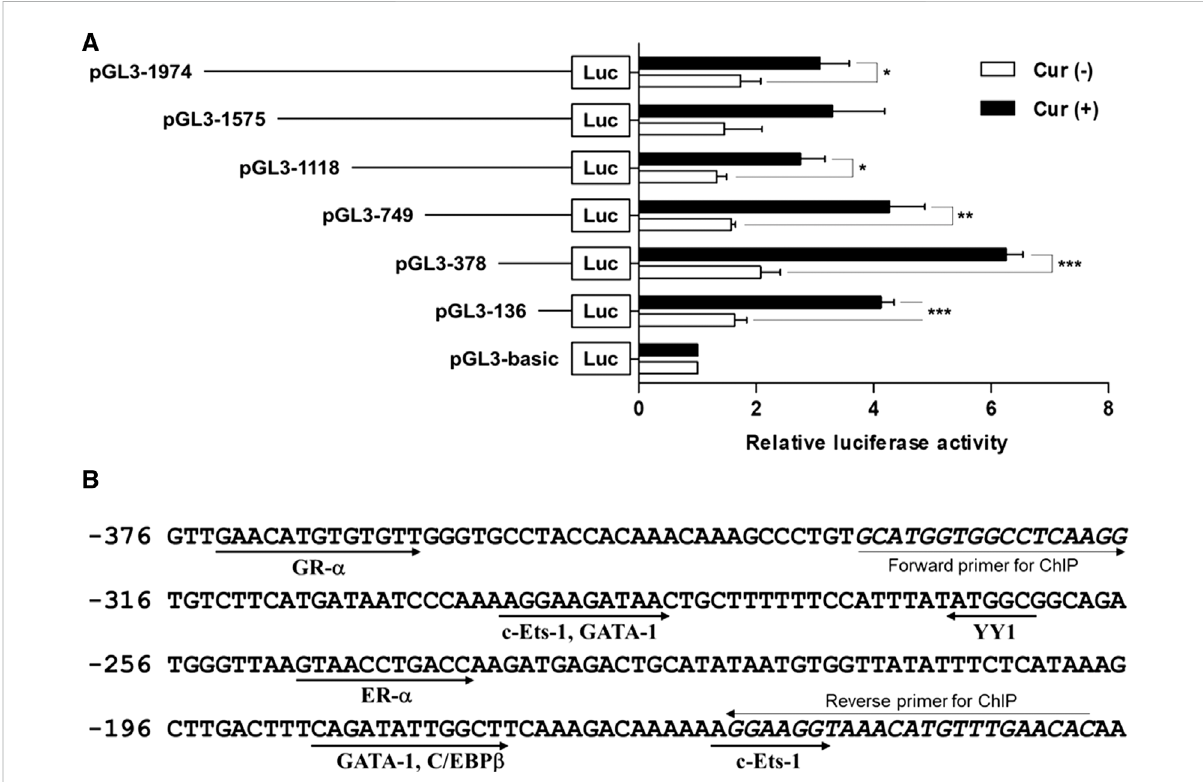
FIGURE 4 AnalysisofthehST6GalNAcIpromoteractivityinHCT116cellstreatedwithcurcumin.(A)SchematicdiagramsshowDNAconstructscontaining different 5 ′ -deletion of the promoter region of the hST6GalNAc I ligated to the luciferase reporter gene. The pGL3-basic construct, which did not containapromoteroranenhancer,wasusedasanegativecontrol.EachconstructwastransfectedintoHCT116cells,withpRL-TKco-transfectedas an internal control. The transfected cells were incubated in the presence (solid bar) or absence (open bar) of 50 µM curcumin for 24 h. Relative fi re fl y luciferase activity was measured using the Dual-Luciferase Reporter Assay System, and all fi re fl y activity was normalized to the Renilla luciferaseactivityderivedfrompRL-TK.Thevaluesrepresentthemeans±SEMofthreeindependentexperimentswithtriplicatemeasurements.* p < 0.05,** p < 0.01and*** p < 0.001comparedwithcurcumin-untreatedcells. (B) Nucleotidesequencesofthepromoterregionfrom-376to-136and putative transcription factor binding sites (TFBS) are shown. TFBS were analyzed by using the ALGGEN-PROMO.v8.3 software with 100% matrix similarity rate. Forward and reverse sequences for ChIP are shown in italic letters